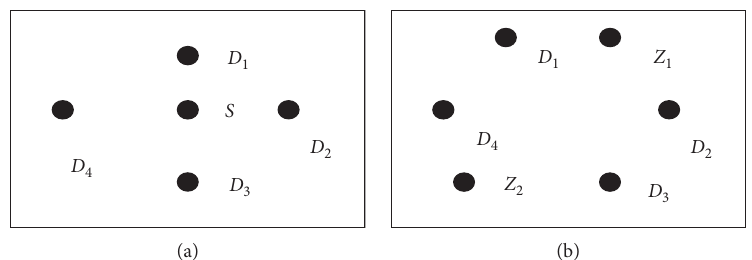
Figure 7: Four nodes detect Sybil attacking topology model. (a) 4 detection nodes and 1 Sybil node topology; (b) 4 detection nodes and 2 normal node topologies.